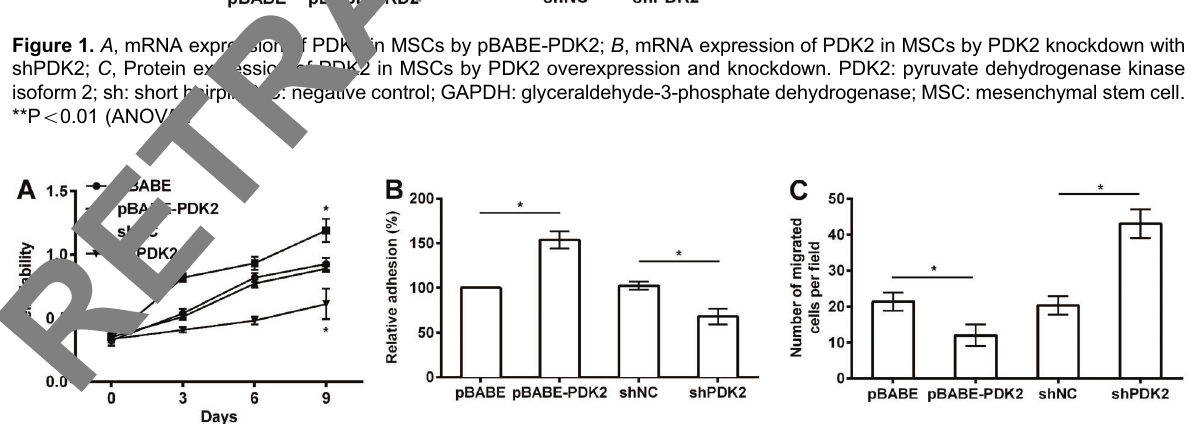
Figure 2. Effects of aberrant PDK2 on cell viability ( A ), cell adhesion ( B ) and cell migration ( C ) in MSCs. PDK2: pyruvate dehydrogenase kinase isoform 2; sh: short hairpin; NC: negative control; MSC: mesenchymal stem cell. Data are reported as means ± SD. *P o 0.05